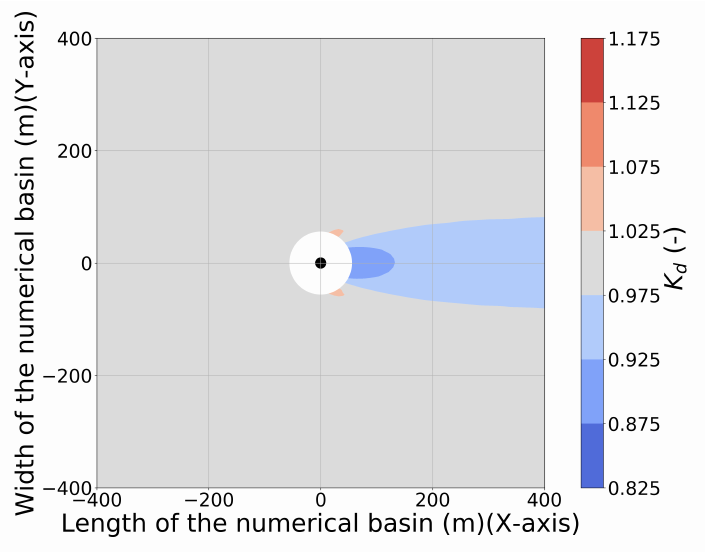
Figure 8. K d , avg disturbance coefficient results for a single HCWEC interacting with short-crested irregular waves with H s = 2.0 m, T p = 8.0 s and s 1 = 15.8. The coupling region is filled using a white solid circle which includes the WEC (indicated by a black solid circle). Incident waves are generated from the left to the